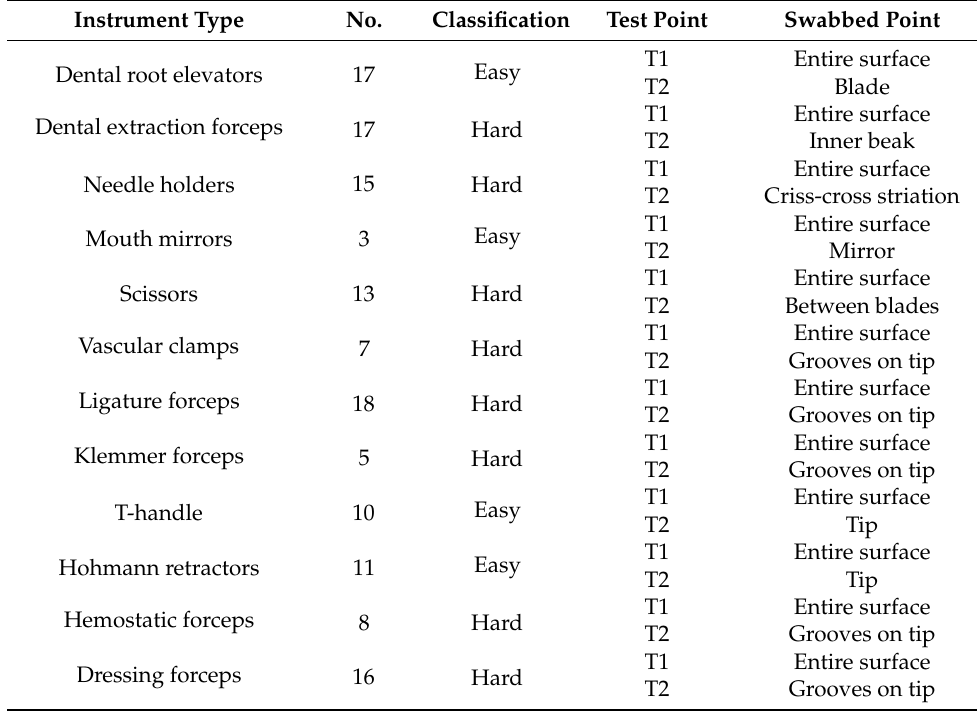
Table 1. Surgical instruments